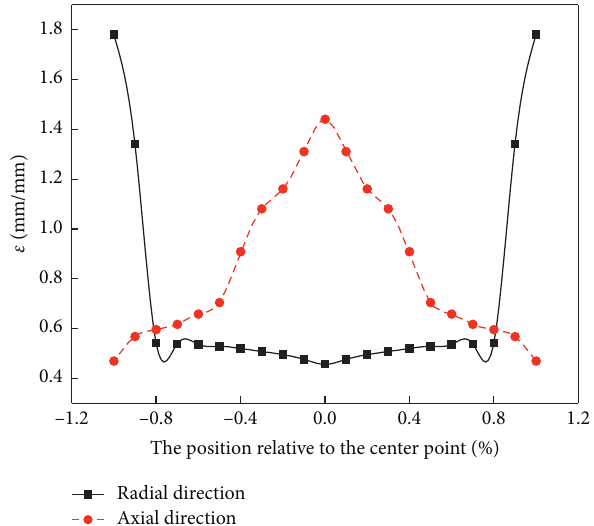
Figure 6: Strain deformation along axial and radial directions of the